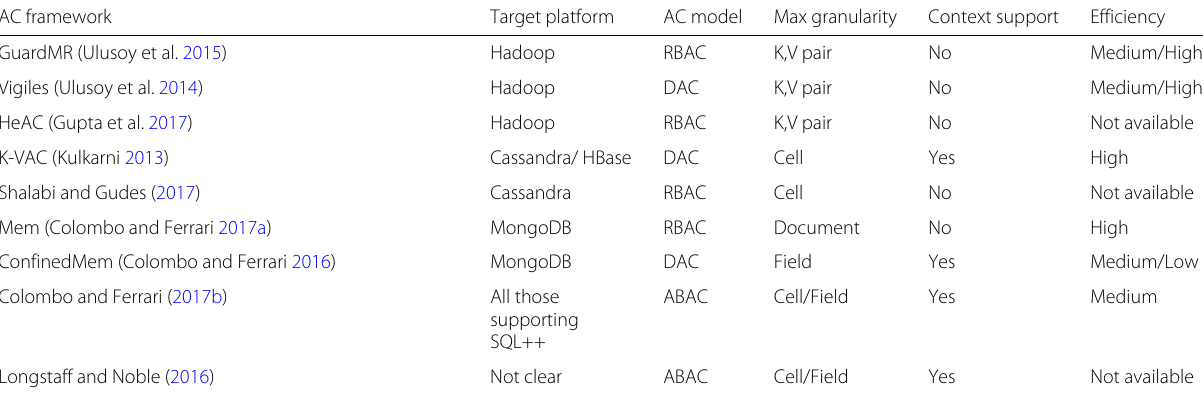
Table 1 Summary of the surveyed platform specific and platform independent access control frameworks AC